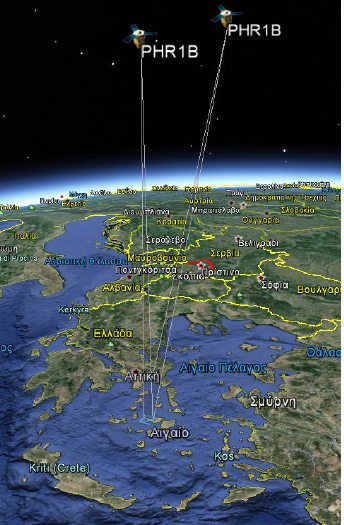
Figure 1. Stereo acquisition for 3D applications (Google Earth preview of the footprints and the satellite's